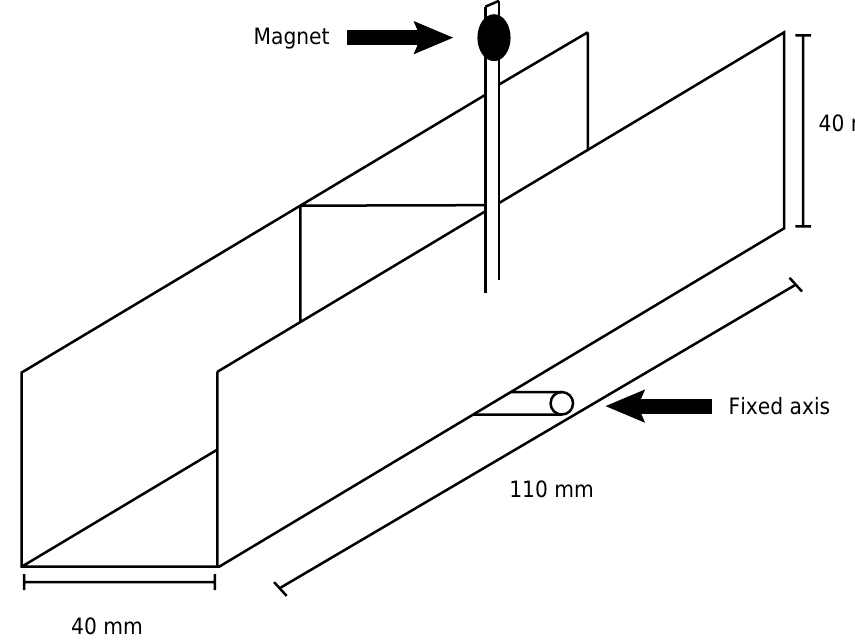
Figure 1. Diagram of the tipping bucket system.